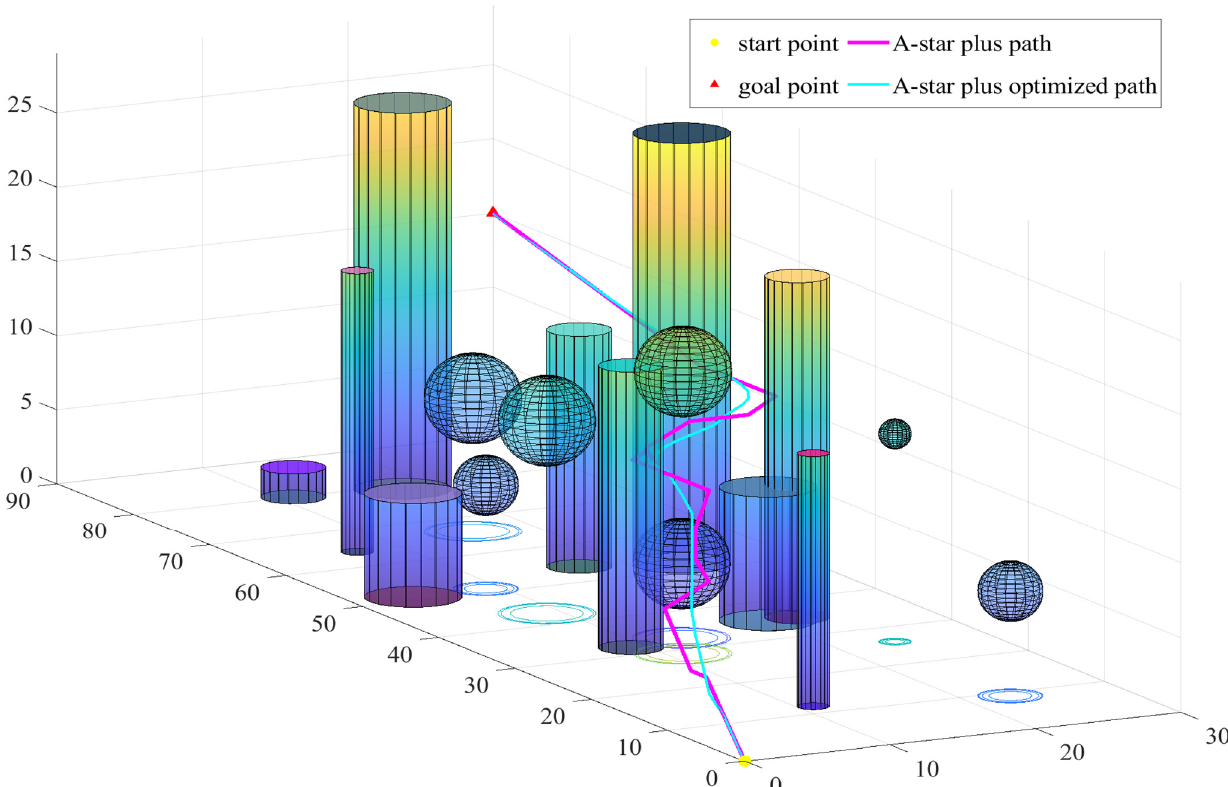
10 of 15 Figure 7. Improved algorithm flow based on A-star algorithm and APFM. 3. Results and Discussion Based on the above path planning algorithm, we created different simulation envi- ronments in Matlab. We set the starting point as the coordinate origin and the location of the target point varies with the size of the map, usually the point farthest from the starting point in the map. In order to simulate the real situation, the number, position and size of obstacles are generated randomly. Due to the complexity of the improved A-star path planning algorithms, we need to use the computing time to evaluate the efficiency of the improved A-star algorithm in the process of path planning and obstacle avoidance for maps of different specifications. The CPU of our computer is Intel(R) Core(TM) i7-8750H CPU @ 2.20GHz 2.21 GHz and the GPU is NVIDIA GTX 1060 Max-Q 6 GB. We have carried out eighty simulation experiments in MATLAB 2022A and taken the average value. To determine the potential